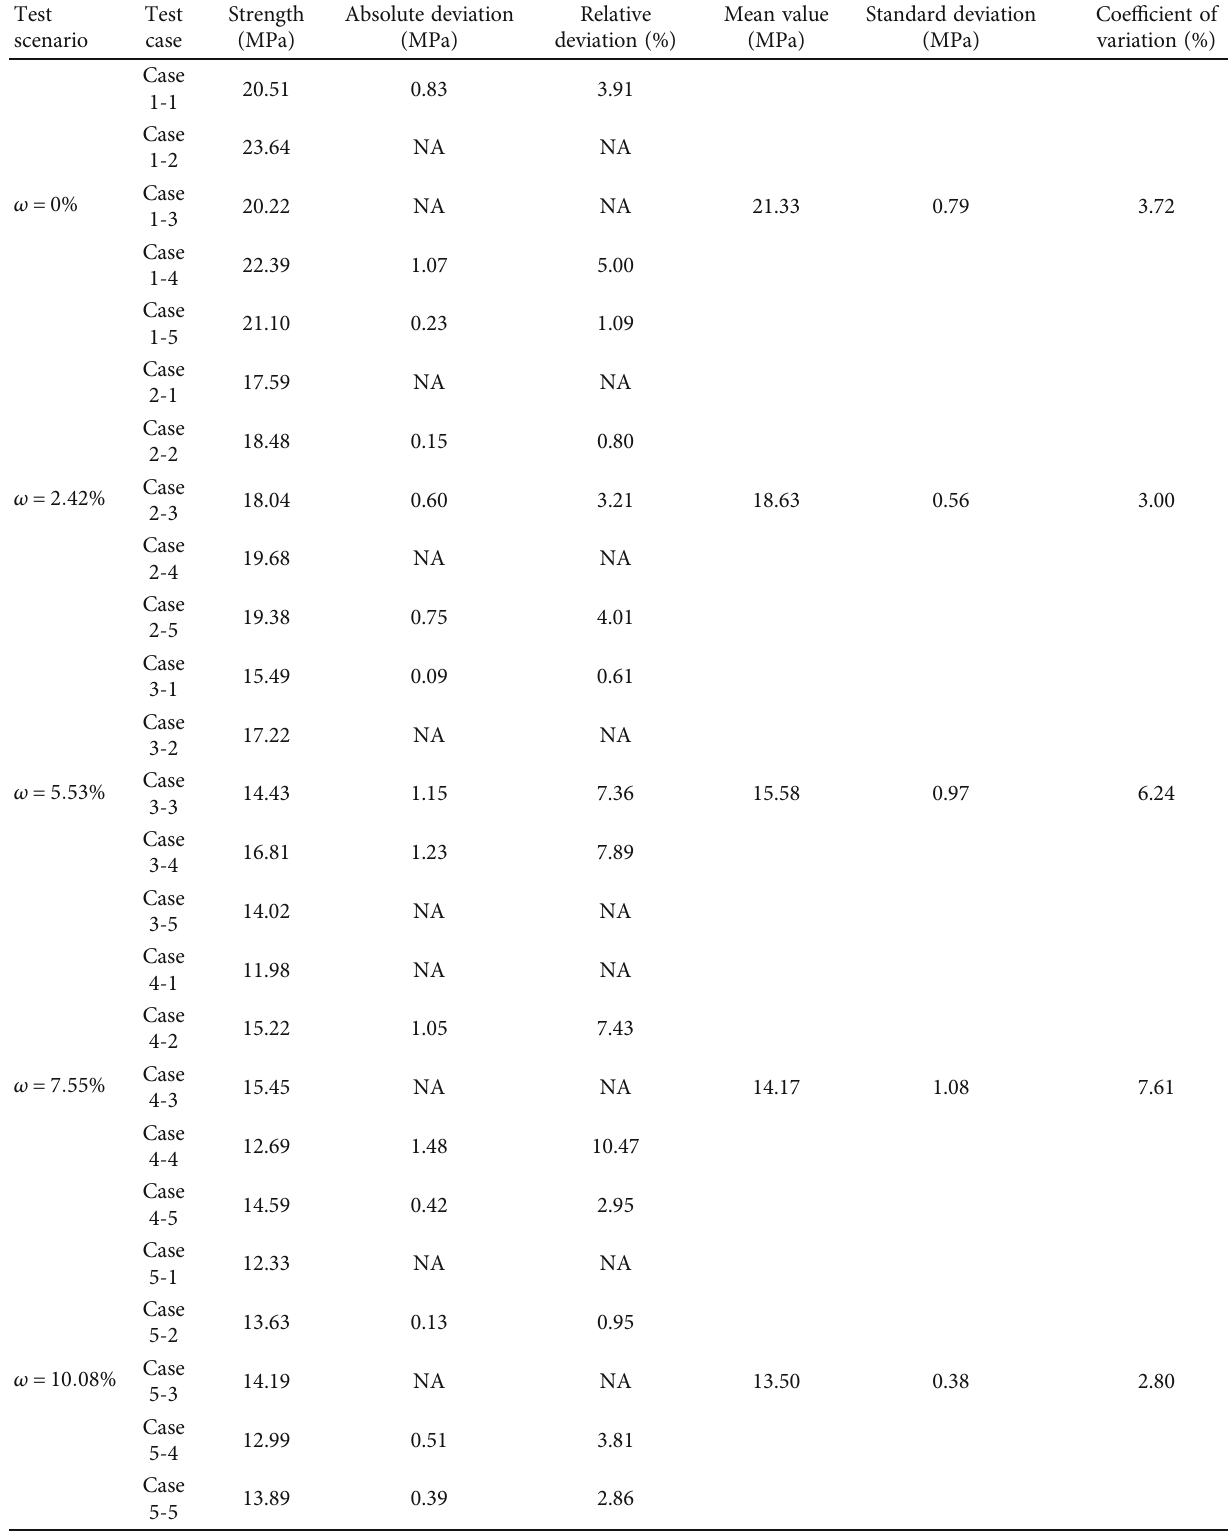
Table 1: Peak strengths of coal sample under di ff erent moisture